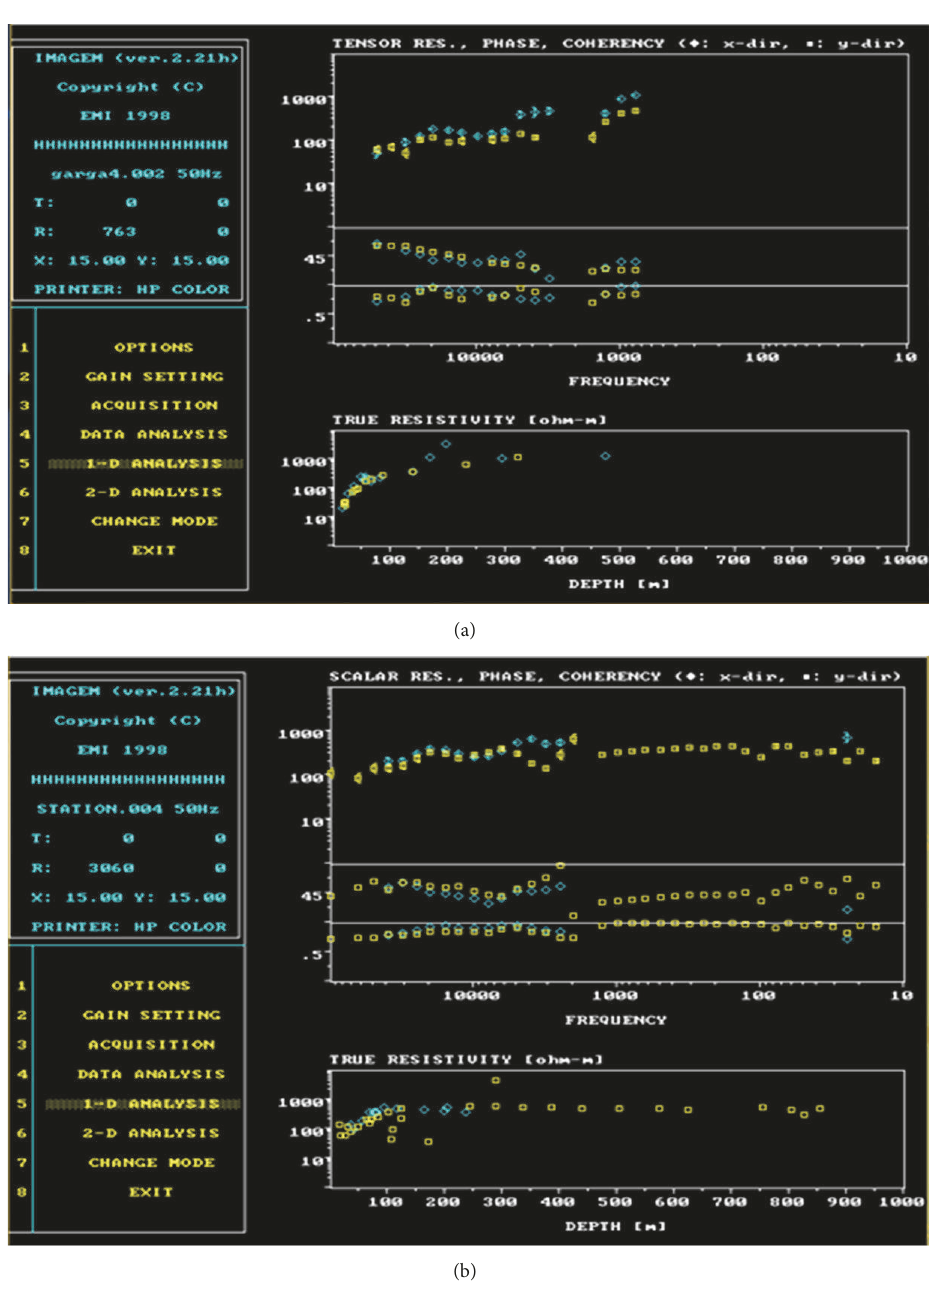
Figure 7: Coherency test from station 2 of the Ndokayo profile (a) and from station 2 of the Oudou